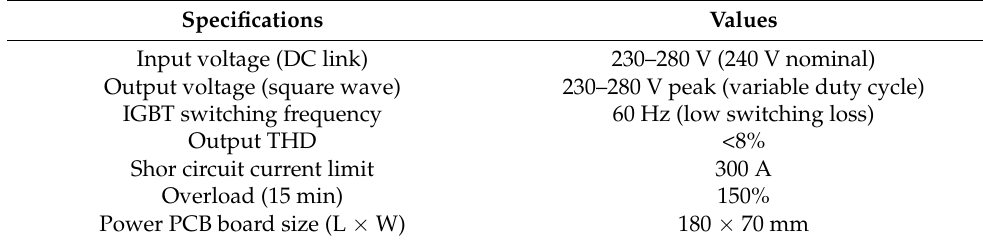
Figure 5. The main components of a full-bridge module. (a) aluminum heat sinks. (b) local CMOS control logic to discard dangerous combinations of power switches. (c) driver stages. (d) DC-link electrolytic capacitors. (e) DC-link low-ESR capacitors. (f) IGBTs. (g) analog comparator for a temperature sensor mounted on the heat sink. Table 1. Design specifications of the implemented full-bridge module (single